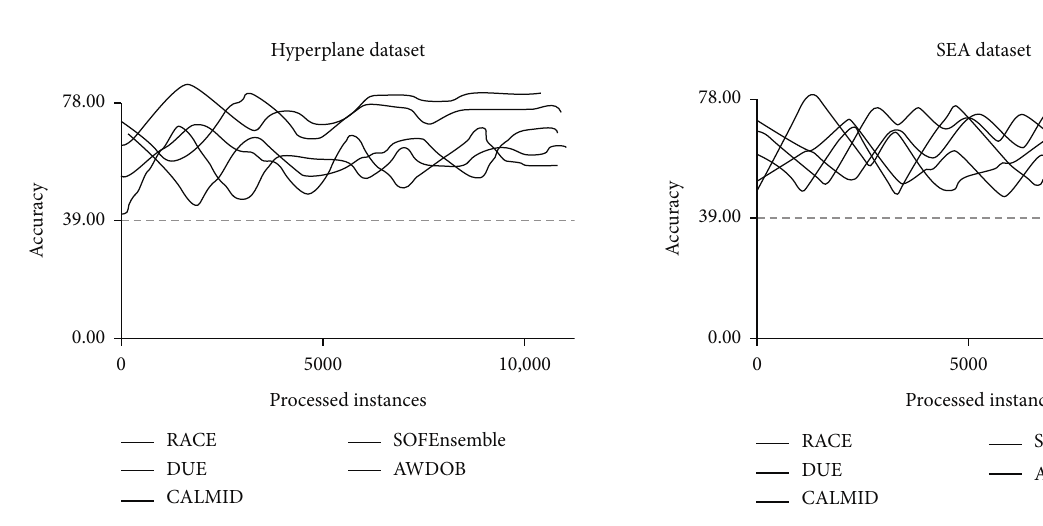
Figure 5: Prediction accuracy of the five algorithms on the SEA dataset.